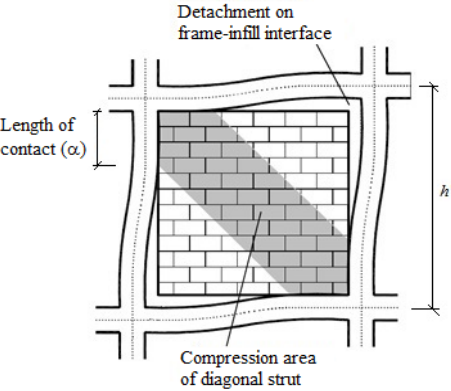
Figure 2. Length of contact between frame and infill. Source: Adapted from Asteris et al.